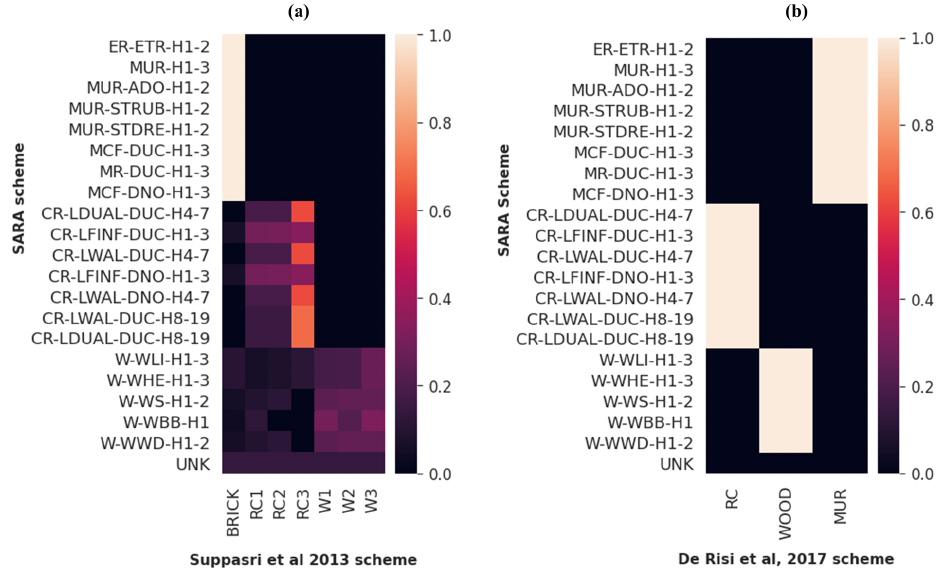
Figure 9. Inter-scheme compatibility matrices for Lima showing the compatibility level between the seismically oriented reference scheme SARA and the tsunami-oriented target schemes: (a) Suppasri et al. (2013) and (b) De Risi et al.